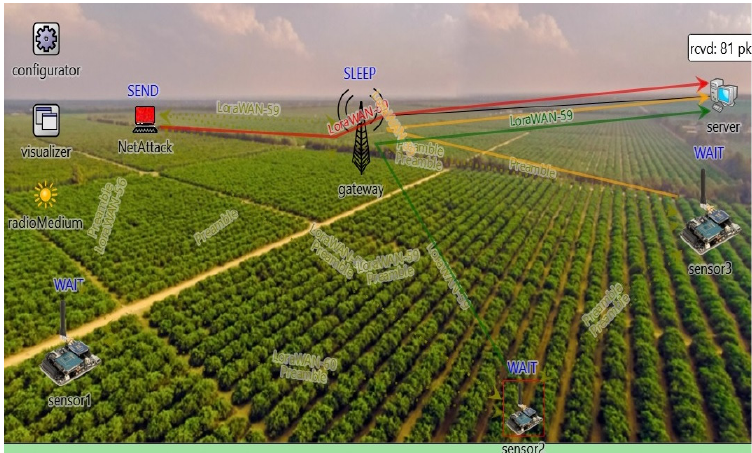
Figure 6. The topology of wireless sensor networks (WSN) for monitoring of agriculture conditions. Sensors 2020 , 20 , x FOR PEER REVIEW